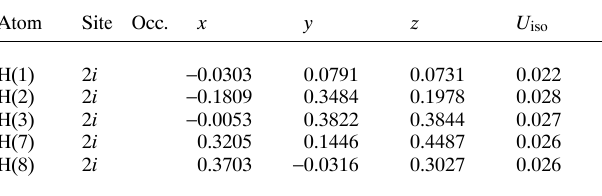
Table 2. A tomic coordin a tes a nd displ a cement p a r a meters (in Å 2 ) .